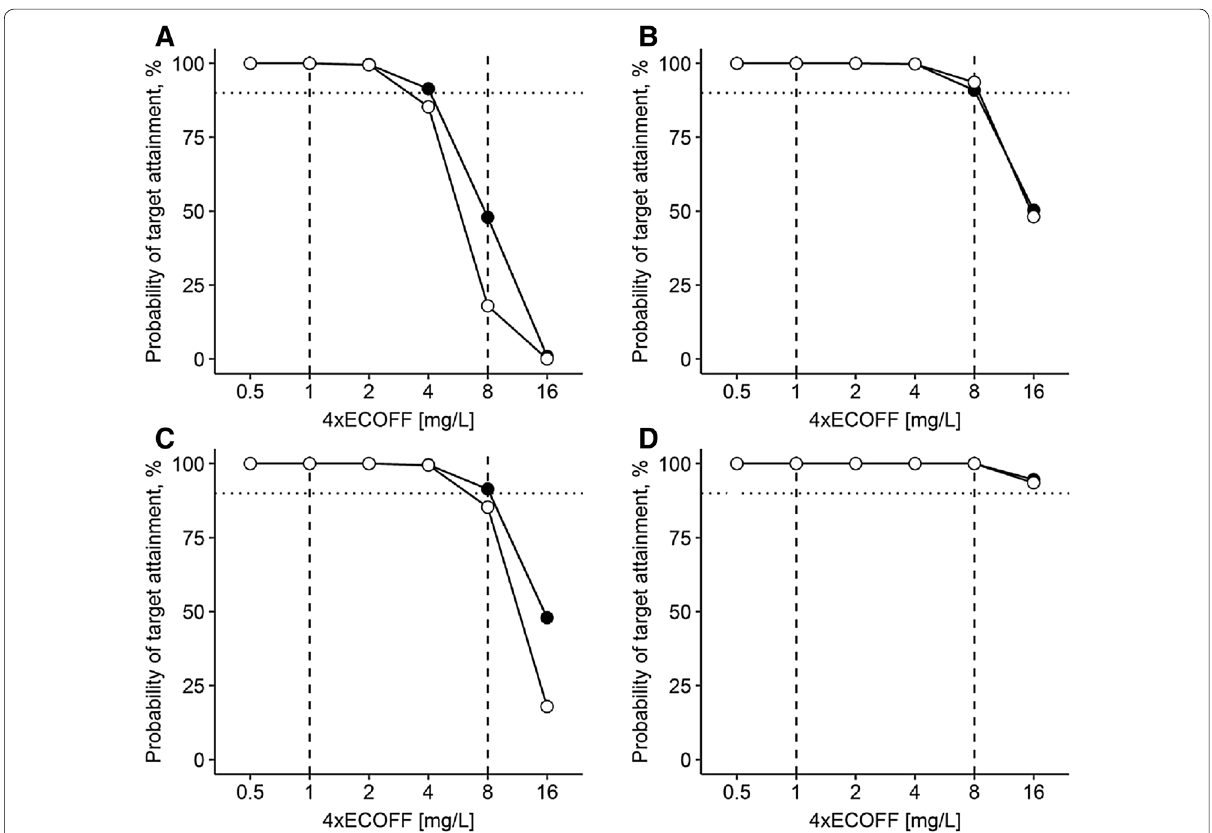
Fig. 1 Probability of target attainment on day 1. a 1 g quid 8 h (30 min); b 2 g loading dose (30 min) followed by 1 g prolonged infusion (over 4 h) quid 8 h; c 2 g quid 8 h (30 min); d 2 g loading dose (30 min) followed by continuous infusion of 3 g/day. Empty dots: patients with acute‑on‑chronic liver failure, closed dots: patients without liver failure, dotted horizontal line depicts probability of target attainment 90%, ≥ dashed vertical lines depict typical target concentrations as 4x European Committee on Antimicrobial Susceptibility Testing epidemiological cut‑off values (ECOFF) for Enterobacterales (4 ECOFF 0.25 mg/L 1 mg/L) and Pseudomonas spp. (4 ECOFF 2.0 mg/L 8 mg/L). MIC minimum inhibitory × = × =